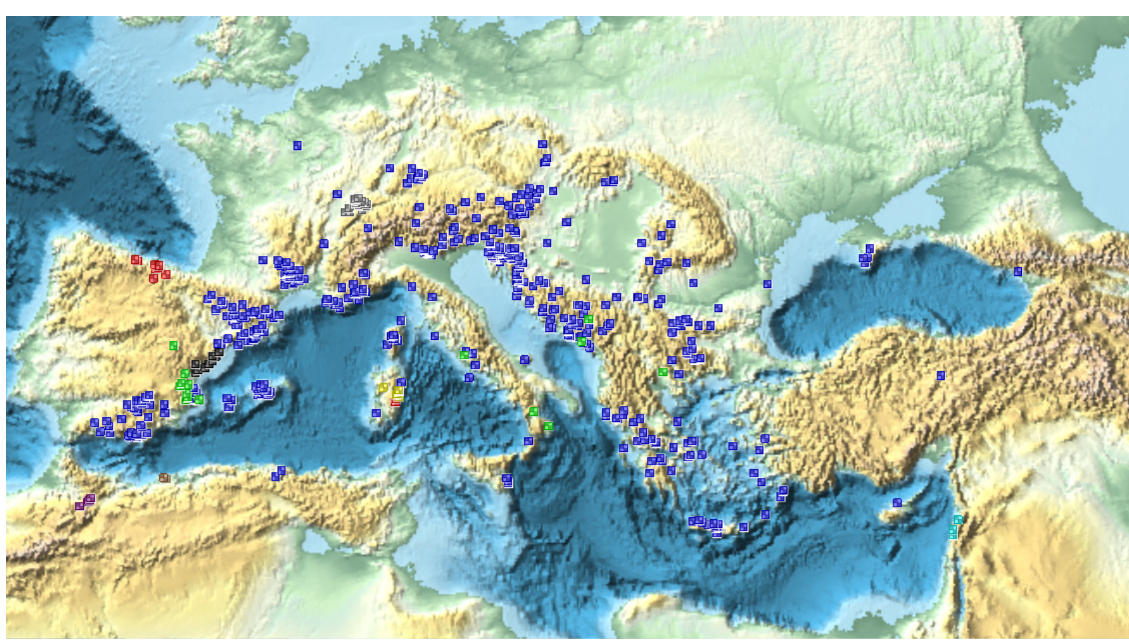
Fig. 210. Distribution map of Plusiocampinae Paclt, 1957 and tachycampoid phyletic group genera in the Euro-Mediterranean area: Cestocampa Condé, 1956 (green squares), Hystrichocampa Condé, 1948 (grey squares), Jeannelicampa Condé, 1952 (brown squares), Oncinocampa Condé, 1982 (red squares), Paratachycampa Wygodzinsky, 1944 (black squares), Patrizicampa Condé, 1956 (yellow squares), Plusiocampa Silvestri, 1912 (navy blue squares), Tachycampa Silvestri, 1936 (violet squares) and Vandelicampa Condé, 1955 (light blue